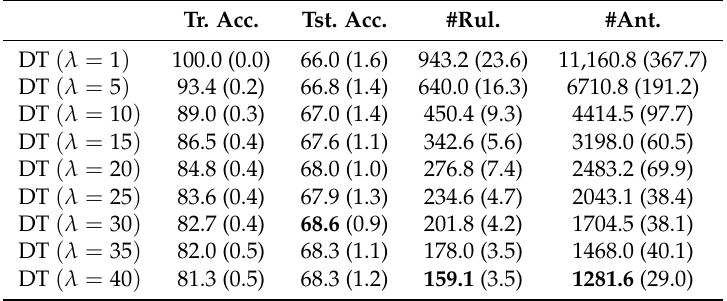
Table 5. Average results obtained by the rules generated from Decision Trees that replace the fully connected layer of CNNs. Columns from left to right represent average results on: Training accuracy; testing accuracy; number of extracted rules; number of antecedents in the rules. In the rows, the λ parameter controlling the size of the trees varies. Tr. Acc. Tst. Acc. #Rul.